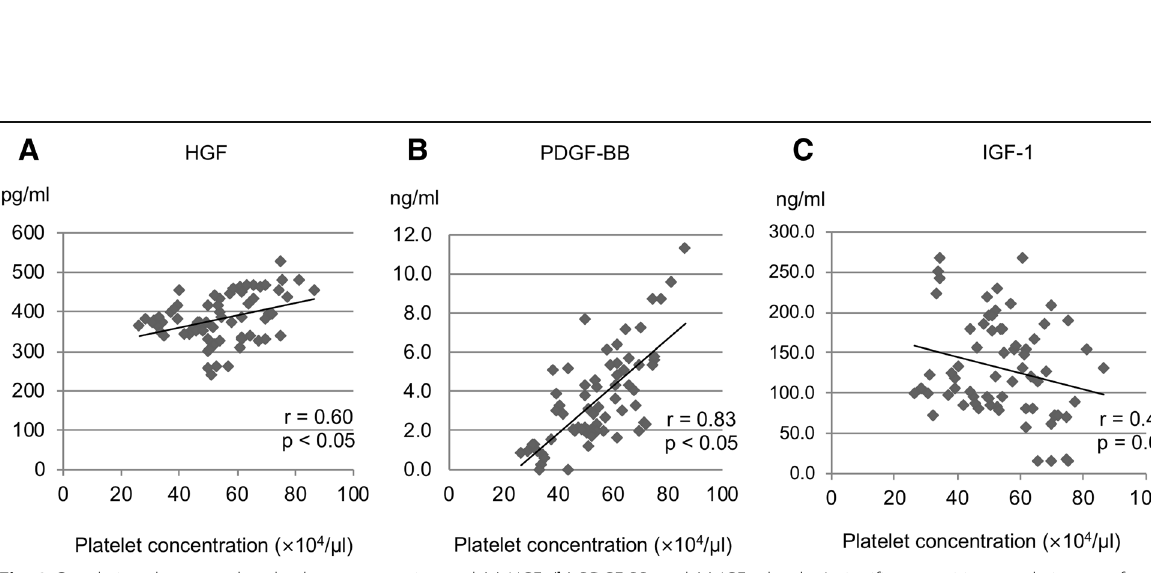
Fig. 3 Correlations between the platelet concentration and ( a ) HGF, ( b ) PDGF-BB, and ( c ) IGF-1 levels. A significant positive correlation was found between the HGF and platelet concentrations (r = 0.60, p < 0.05), and between the PDGF-BB and platelet concentrations (r = 0.83, p <